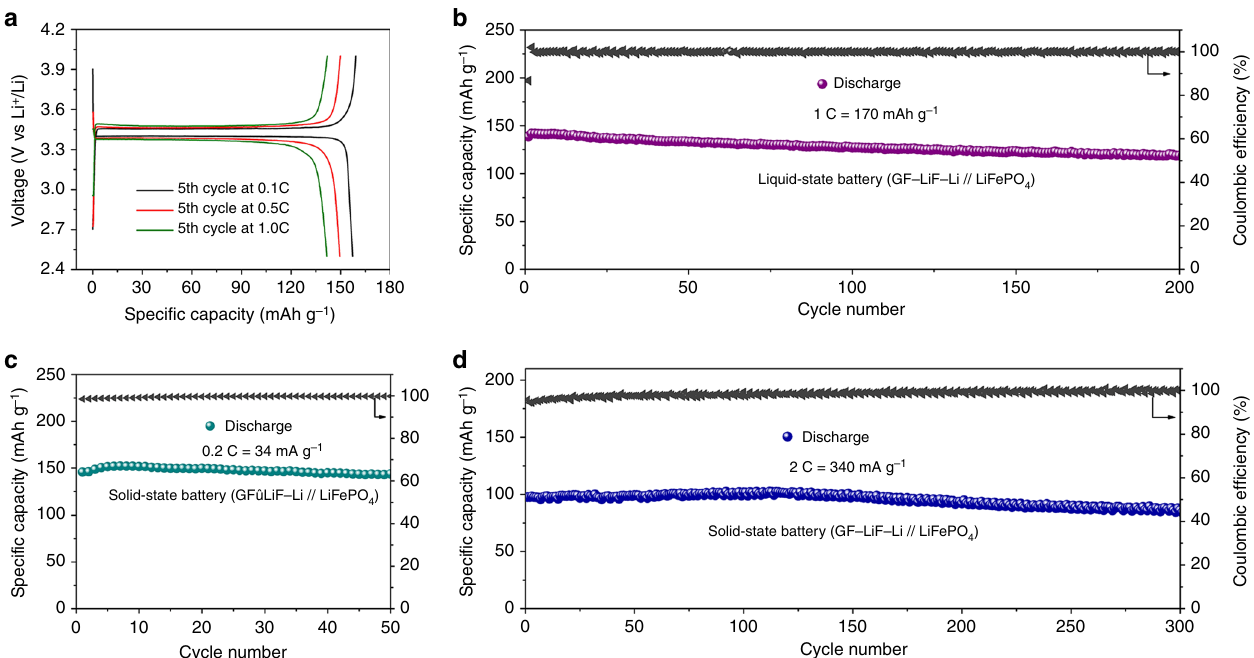
Fig. 5 Galvanostatic cycling performance of GF – LiF – Li anodes. Characteristic charge – discharge voltage pro fi les of ( a ) liquid-state GF – LiF – Li/LiFePO 4 cells at different current densities. The cycling performance of ( b ) liquid-state GF – LiF – Li/LiFePO 4 cells. Cycling stability of all-solid-state GF – LiF – Li/LiFePO 4 cells at a current rate of ( c ) 0.2 C and ( d ) 2